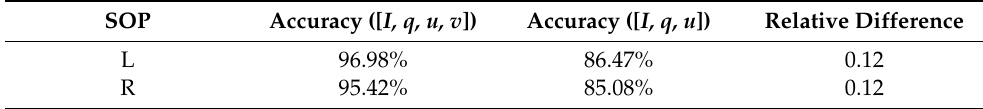
Table 5. Classification Isochrysis and Chattonella marina .